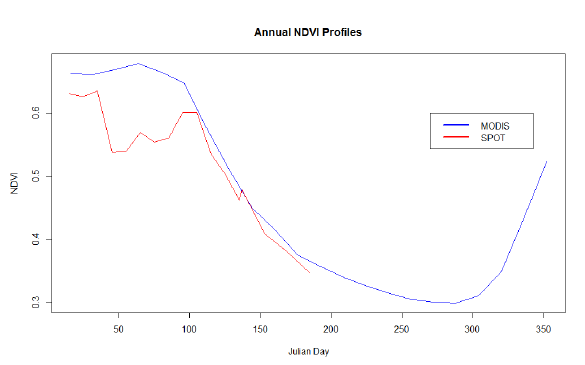
Figure 4. NDVI profile from SPOT and